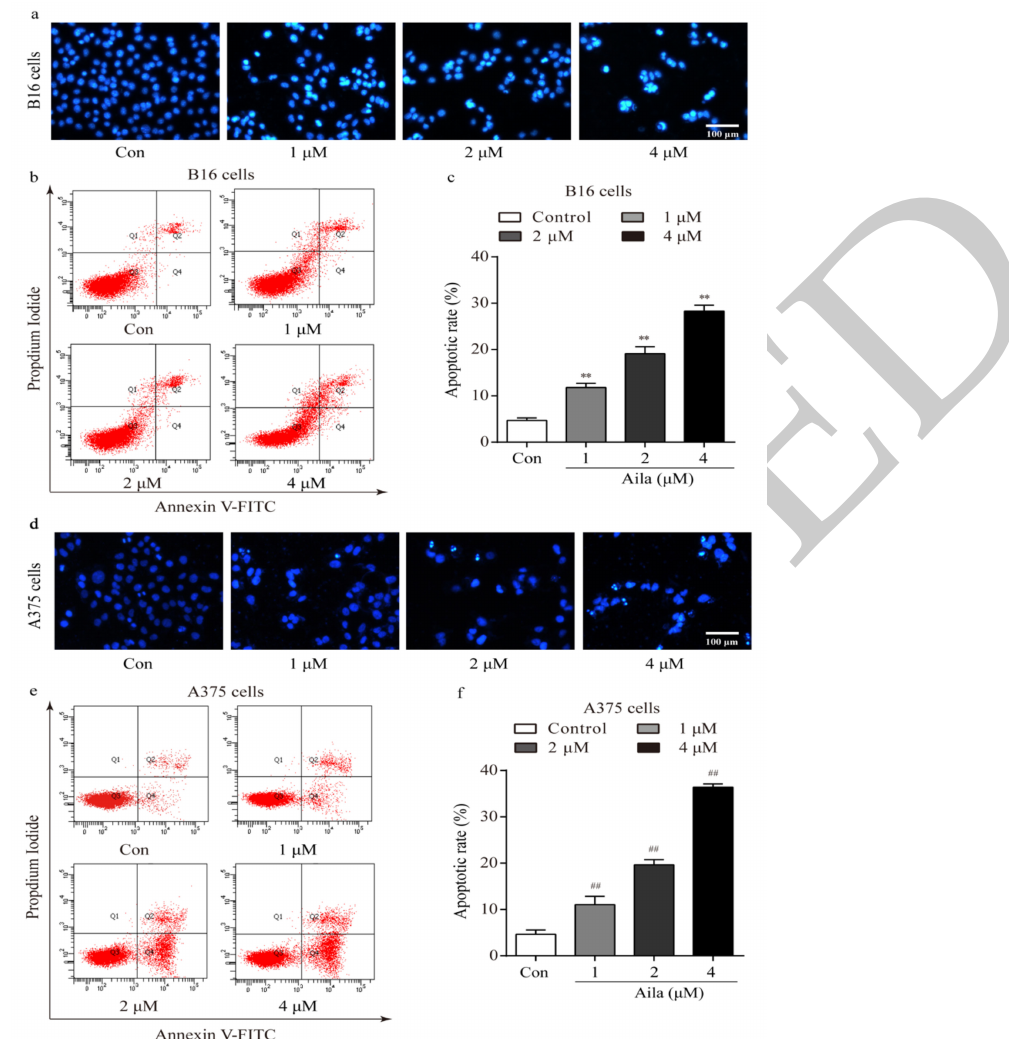
Figure 5. Ailanthone induces cell apoptosis in melanoma B16 and A375 cells. ( a ) Representative morphological images of ailanthone-treated B16 cells after Hoechst 33258 staining. ( b ) The apoptotic rates of ailanthone-treated B16 cells were measured by flow cytometry. ( c ) Quantitative analysis of the apoptotic rates of ailanthone-treated B16 cells. ** p < 0.01 compared with the control B16 cells. ( d ) The representative morphological images of ailanthone-treated A375 cells after Hoechst 33258 staining. ( e ) The apoptotic rates of ailanthone-treated A375 cells were measured by flow cytometry. ( f ) Quantitative analysis of the apoptotic rates of ailanthone-treated A375 cells. ## p < 0.01 compared with the control A375 cells. The data are presented as the mean ± SD ( n =